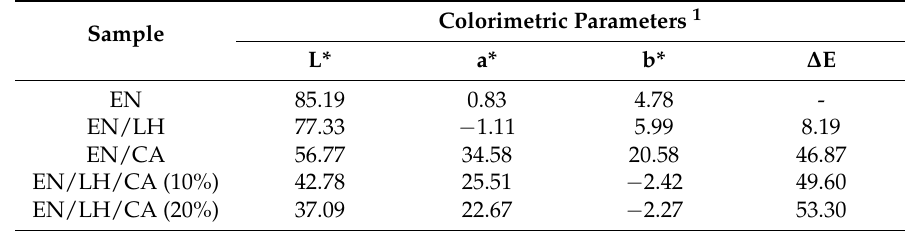
Table 3. Color coordinates of the EN composites containing LH, carminic acid, and hybrid pigments. Sample